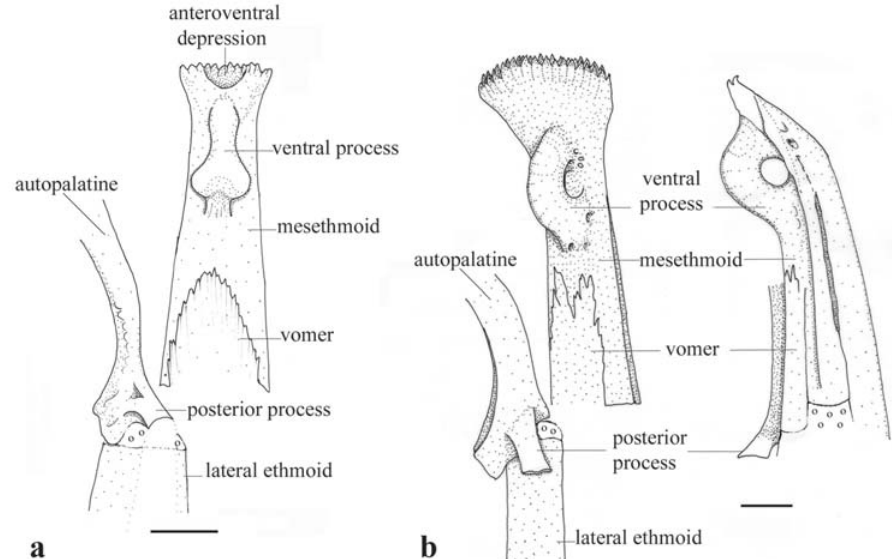
Fig. 15. Ventral view of mesethmoid, lateral ethmoid, anterior portion of vomer, and posterior portion of autopalatine of Lamontichthys filamentosus (LACM 41741-9, 119.4 mm SL) (a), and L . avacanoeiro (MZUSP 61974, 113.7 mm SL, paratype) (b, left). Lateral view of these structures (b, right). Scale bar = 1 mm.